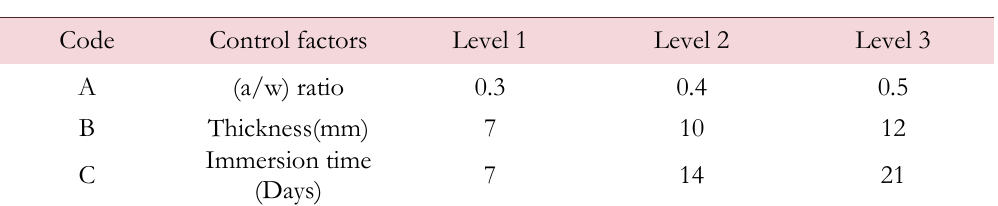
Table 2: Factors and levels